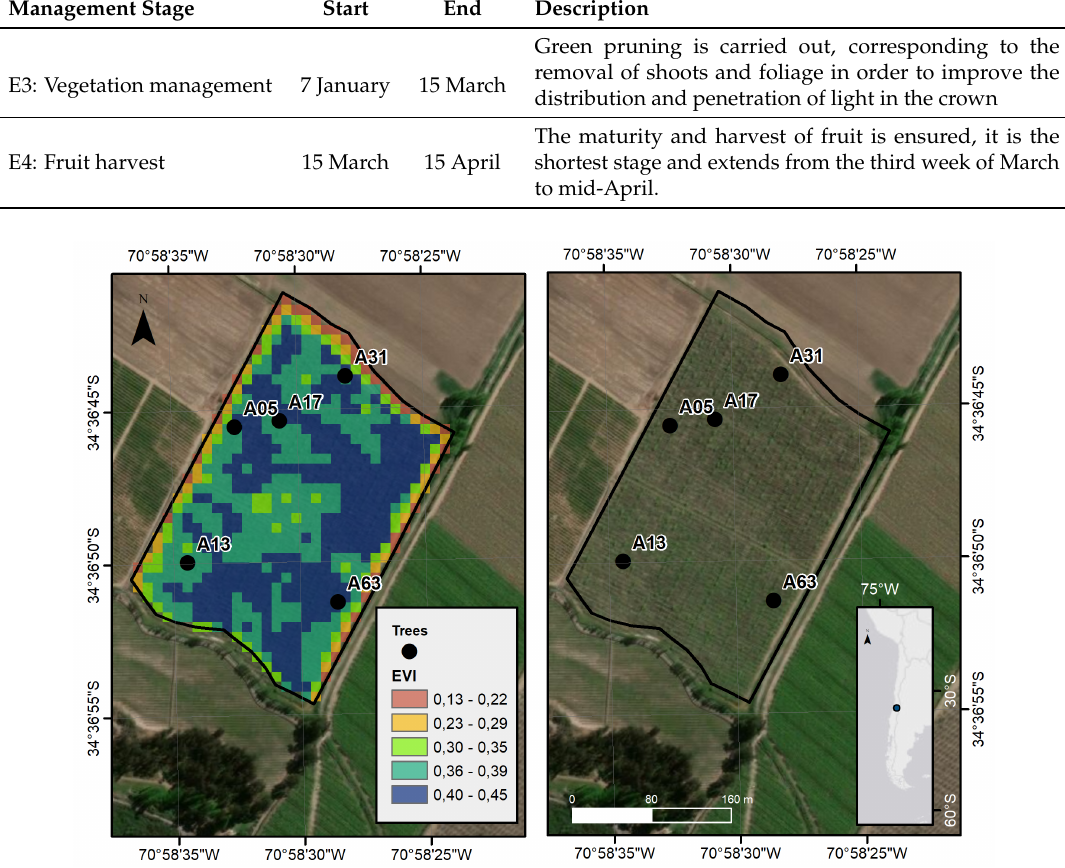
Figure 1. Study area of Kiwifruit orchard on El Carmen agricultural high school, San Fernando, Chile.